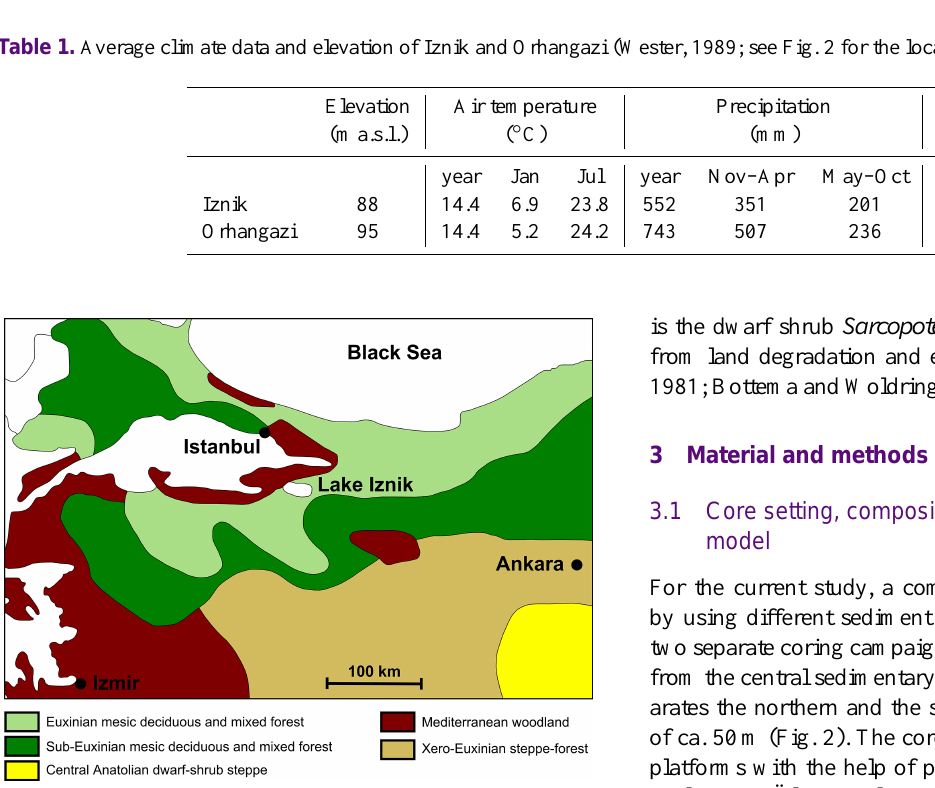
Figure 3. Natural potential vegetation of northwestern Turkey re- drawn from Zohary